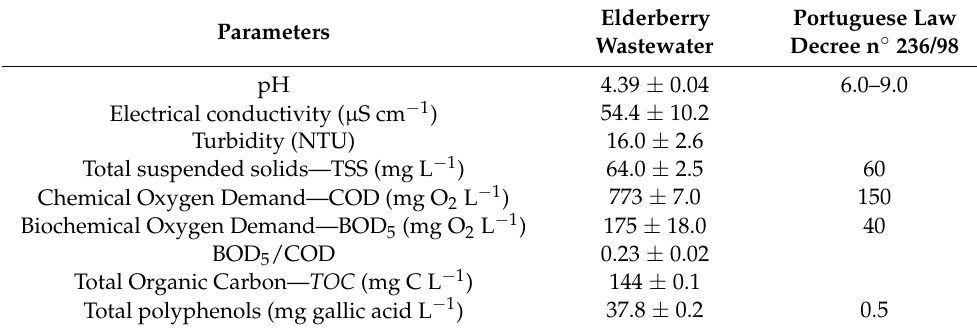
Table 1. Elderberry wastewater characterization and legal limits for treated water release.